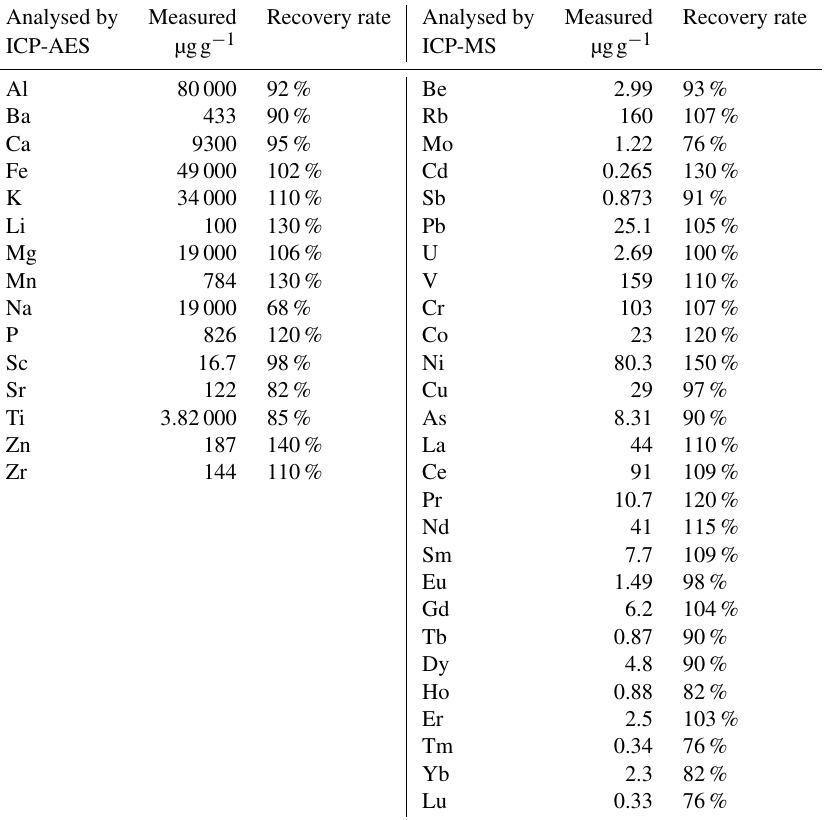
Table B1. MAG-1 recovery rates. Elements have a recovery rate between 68% and 130%, except for Zn and Ni. The very low amount of geostandard used ( < 10mg) could explain the difference observed in recovery rates because subsampling heterogeneity is possible with such small amounts. Zn and Ni are overestimated, probably due to